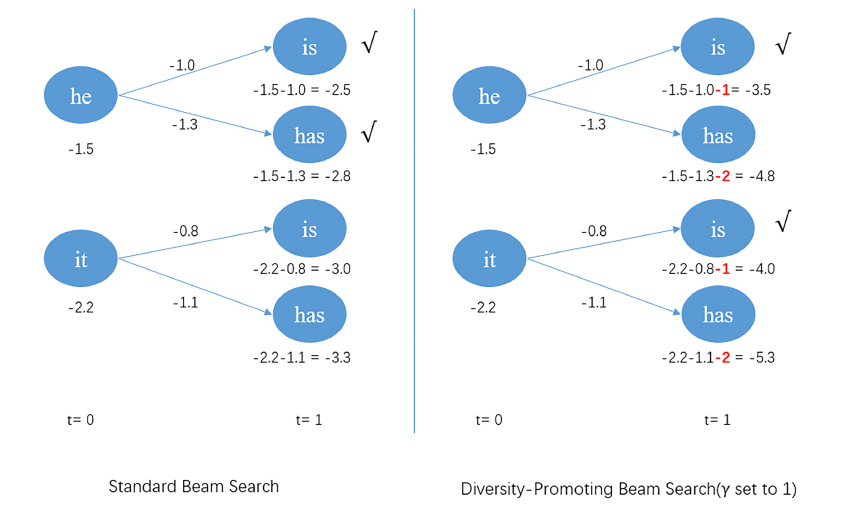
Figure 3. Illustration of standard beam search and the proposed diversity-promoting beam search. Note that this is only the initial part of the diversity-promoting process. After the candidates have diverged sufficiently, we turn to using the grouping